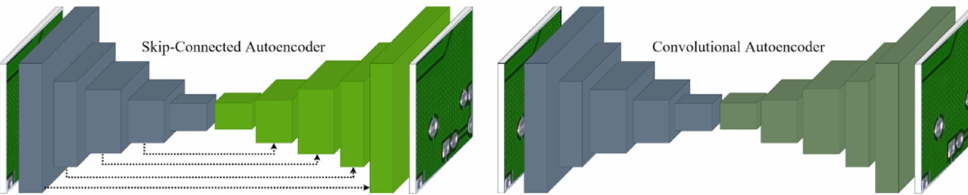
Figure 5. Architectures of the skip-connected convolutional autoencoder and convolutional autoencoder. The arrows indicate the skip